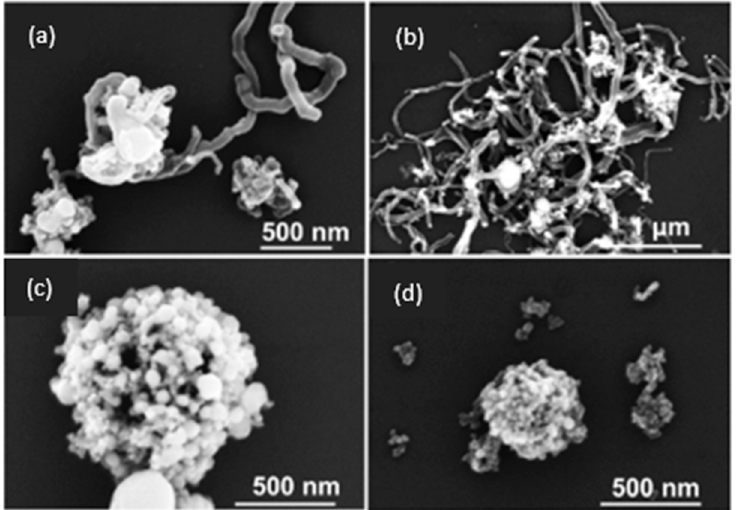
Figure 9. ( a , b ). SEM images shown whisker carbon fibers were deposited on the surface of 10Ni-0Ce- 1Al and 10Ni-0Ce-5A1 ( c , d ). SEM images shown no fibril carbon on the surface of 10Ni-Ce-1Al